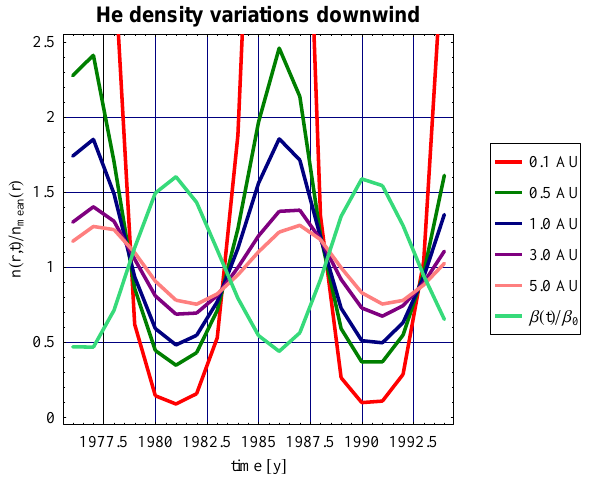
Fig. 4. Deviations of helium density from the mean values dur- ing the solar cycle, at the upwind axis at selected distances from the Sun: shown is the quantity n (cid:0) r,θ = 0 ◦ ,t (cid:1) /n mean (cid:0) r,θ = 0 ◦ (cid:1) com- puted at the distances indicated in the box next to the figure. Also shown (for reference purposes) is the variation of the photoioniza- tion rate assumed to the mean value, marked “ β (t)/β 0 ”.